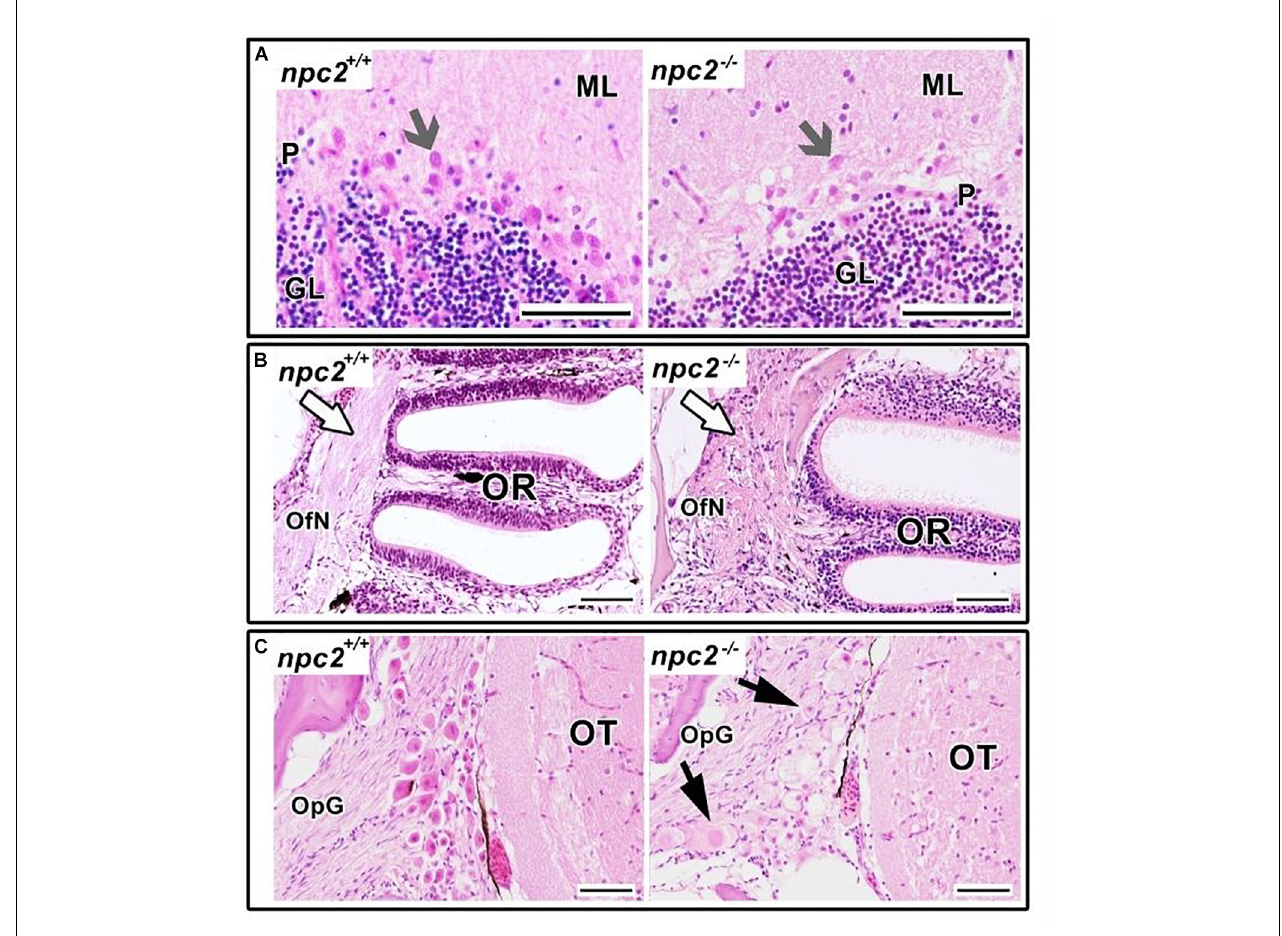
FIGURE 7 | Pathological changes in npc2 − / − sensory organs. (A) Cerebellum structure with Purkinje cells degeneration in npc2 mutant (gray arrow), (B) Olfactory rosette with olfactory nerves (white arrow). (C) Optic nerve ganglion. Cells with a foamy, pale cytoplasm, eosinophilic nuclei, and signs of degeneration (black arrows) within the optic tectum. (A) ML, molecular layer; P, Purkinje cell leyer; GL, granule cell layer; OfN, olfactory nerves; and OR, olfactory rosette; (B) OT, optic tectum; OpG, optic nerve ganglion. H&E staining. Scale bar = 50 µ m.